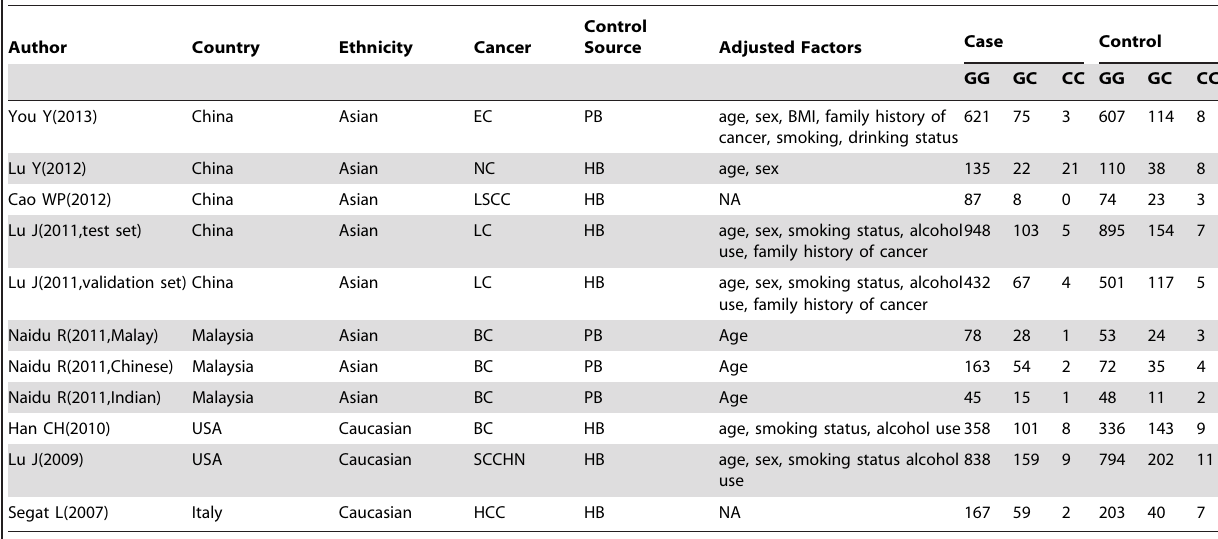
Table 1. Characteristics of included